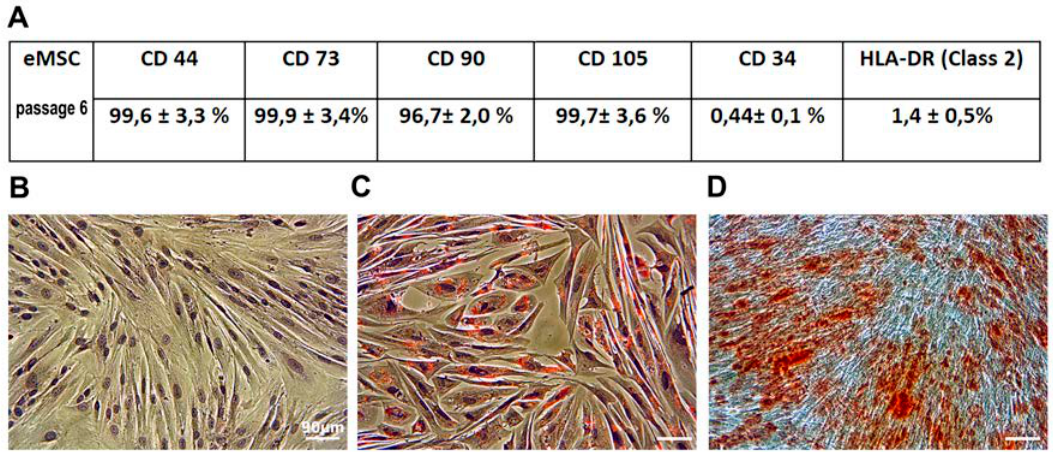
Figure 1. MSC CD marker expression ( A ) and capacity for differentiation into adipocytes ( C ) and osteoblasts ( D ), ( B ) Initial (control at the passage 6) cells were not subjected to differentiation stimuli. Ob: 10×, scale bar = 90 μm.